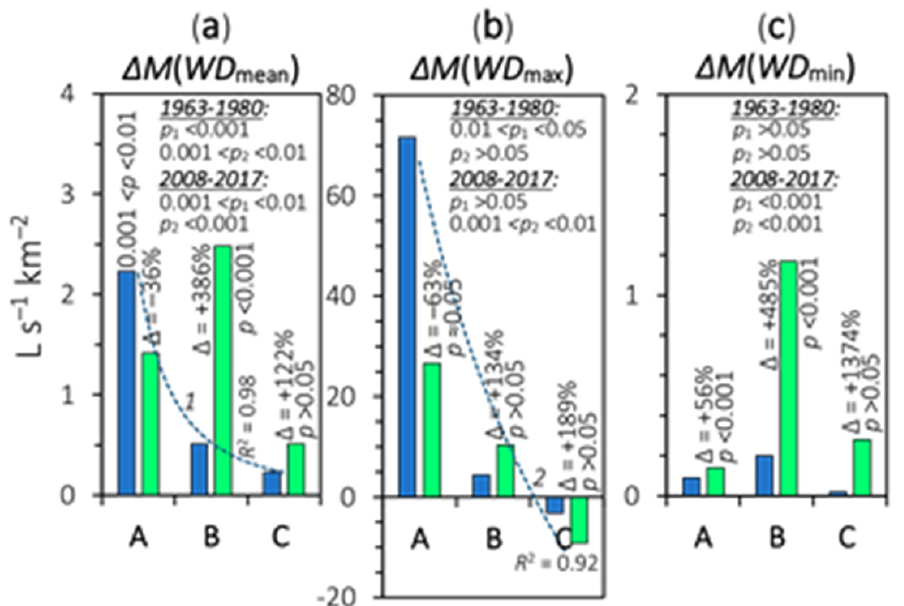
Figure 5. Changes in differential specific water discharge (see Equation (1)) of the Kalaus River at the analyzed hydrological stations (see Figure 1; Table 1) between 1963–1980 (in blue color) and 2008–2017 (in green color). Differential specific water discharge: ∆ M ( WD mean )—averaged mean annual ( a ); ∆ M ( WD max )—averaged maximal (per annum) ( b ); ∆ M ( WD min ) — averaged minimal (per annum) ( c ). The sub-basins of the Kalaus River basin: A—upriver of Sergiyevka (1590 km 2 ); B— between Sergiyevka and Svetlograd (2950 km 2 ); C—between Svetlograd and Vozdvizhenskoye (4560 km 2 ); ∆ —relative changes between 1963–1980 and 2008–2017; the probability of statistically significant difference (the Student’s t -test) between: p –1963–1980 and 2008–2017, p 1 –A and B, p 2 –B and C; R 2 —the coefficient of trend line approximation for 1963–1980 ( 1 —the power trend line; 2 — the logarithmic trend line).